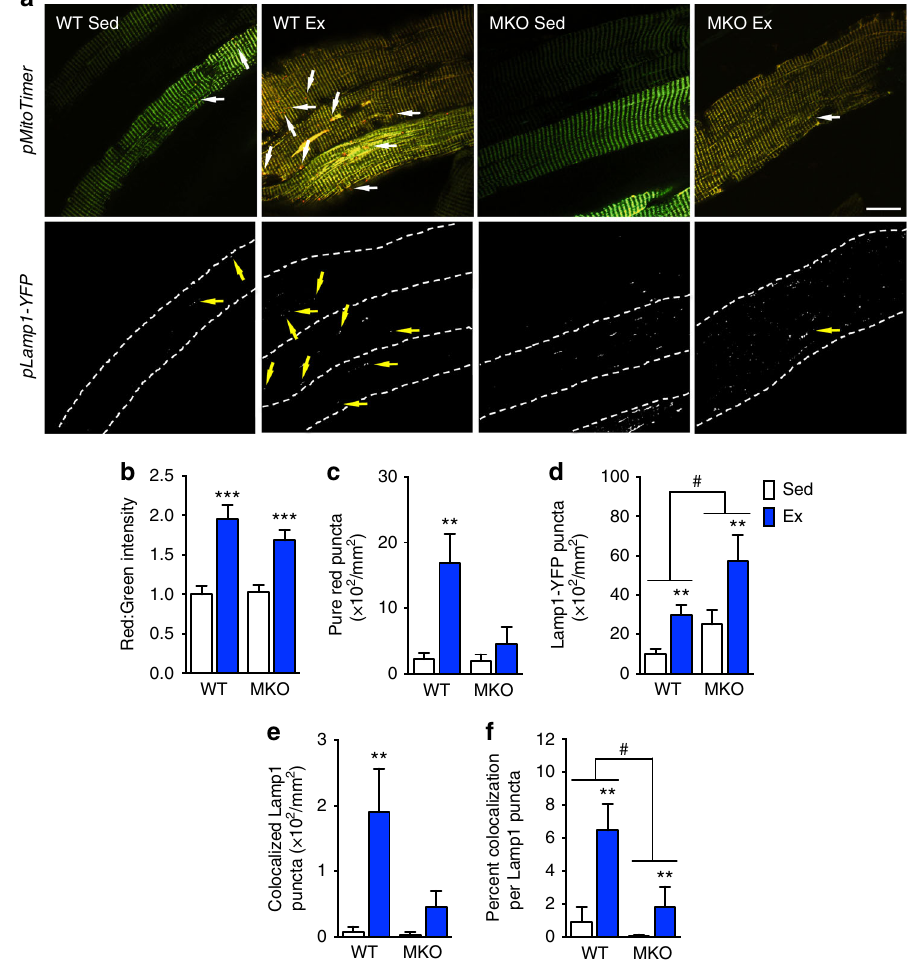
Fig. 6 Ulk1 is required for acute exercise-induce mitophagy in skeletal muscle. a Representative images of WT and Ulk1 MKO mouse FDB fi bers co-transfected with pMitoTimer and Lamp1-YFP. Scale bar = 20 µ m. Quanti fi cation of b red : green fl uorescence intensity, c pure red MitoTimer puncta (interaction effect p = 0.03), d total Lamp1-YFP puncta per fi ber area, e co-localized Lamp1-YFP puncta per fi ber area (interaction effect p = 0.1), and f percent co-localization of MitoTimer pure red puncta with Lamp1-YFP puncta (interaction effect p = 0.05). Data presented as mean ± standard error of the mean. n = 6 (12 – 13 weeks), ** p < 0.01 and *** p < 0.001 for sedentary vs. exercise comparisons. # p < 0.05 for between group